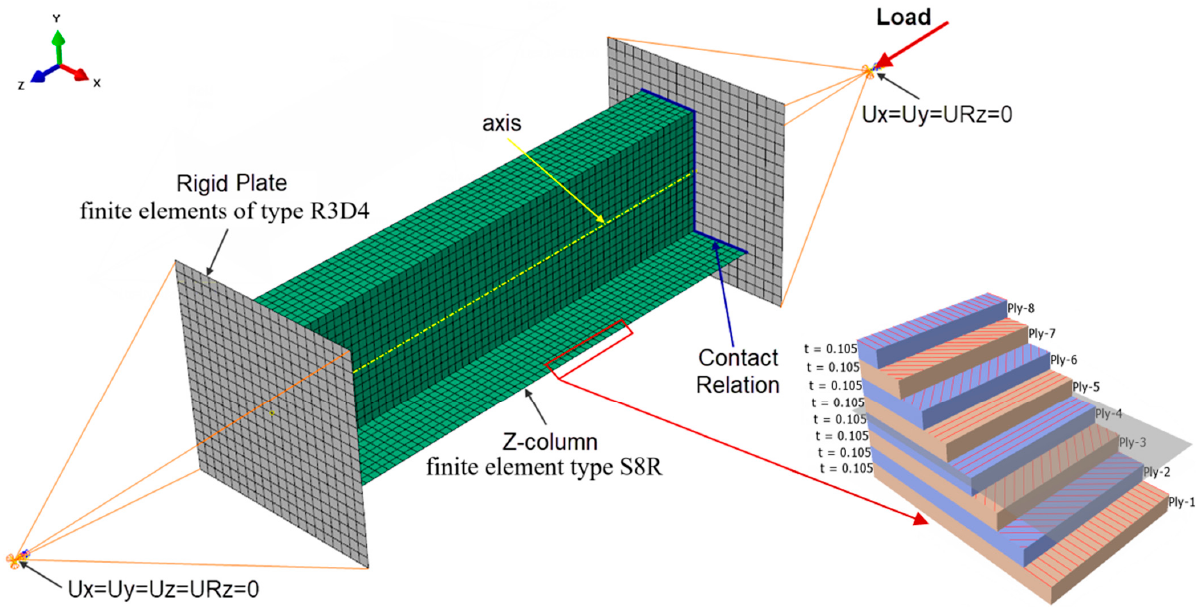
Figure 5. FEM model of the Z-column with boundary conditions and composite structure after the thickness of the shell element.